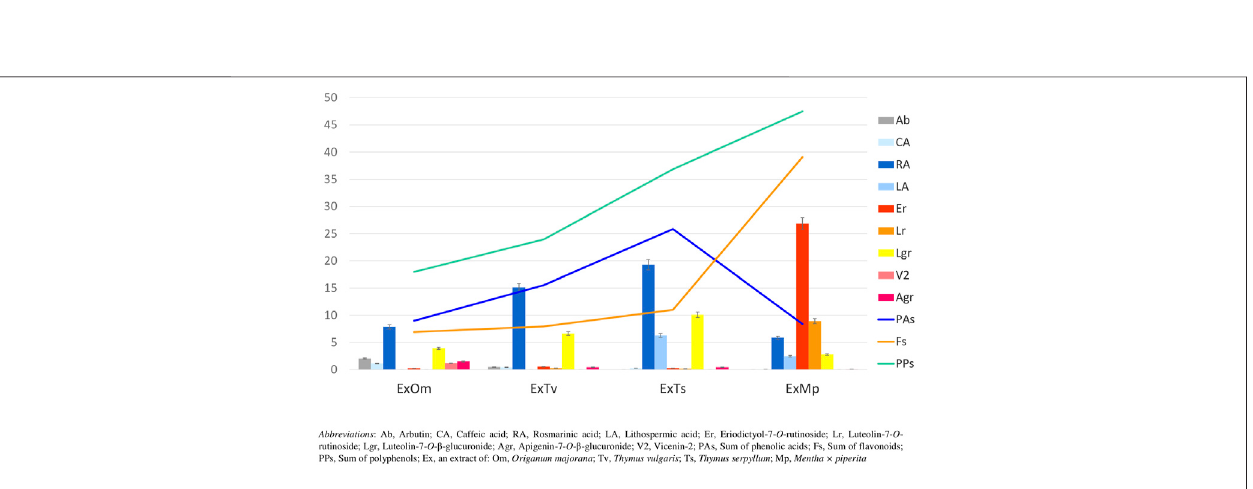
Frontiers in Pharmacology |